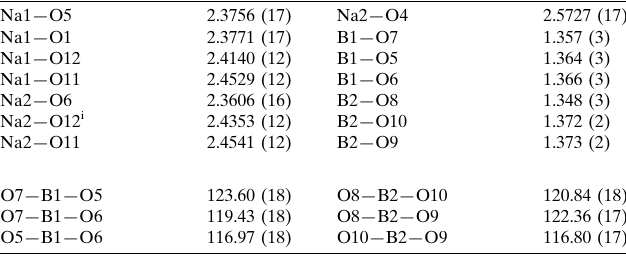
Selected geometric parameters (A˚ , (cid:5) ).